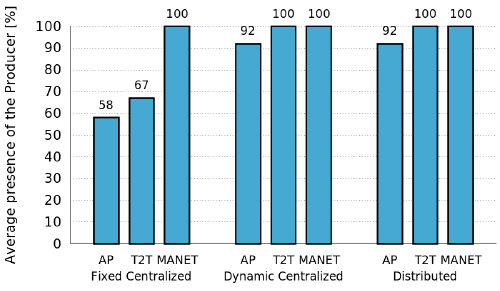
Figure 8. Performance of the Control Tier for different network infrastructures.